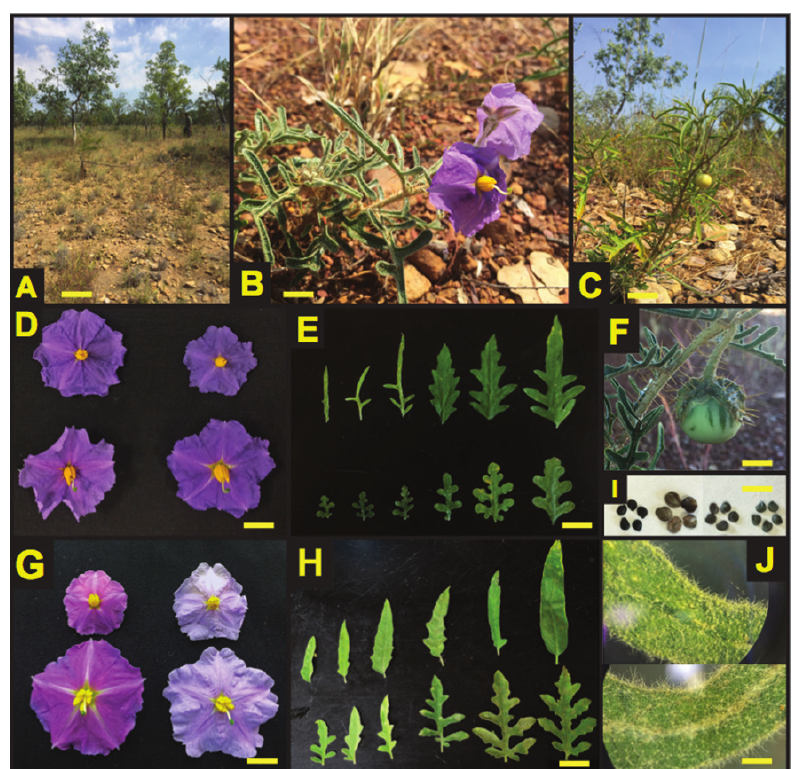
Figure 2. Solanum jobsonii Martine, J.Cantley, and L.M.Lacey and related species. A Typical habitat in clay soils with limestone stones and laterite pebbles, Limmen National Park, NT B S. jobsonii in flower and C in mature fruit D Corolla comparisons of staminate (upper) and hermaphrodite (lower) flowers for S. jobsonii (left) and S. diversiflorum (right) E Leaf shape across varying leaf ages for S. jobsonii (top) and S. diversiflorum (bottom) F S. jobsonii immature fruit with armed calyx G Corolla comparisons of staminate (upper) and hermaphrodite (lower) flowers for S. eburneum (left) and S. watneyi (right) H Leaf shape across varying leaf ages for S. watneyi (top) and S. eburneum (bottom) I Seed size, shape, and color comparisons from left to right – S. jobsonii , S. diversiflorum , S. eburneum , and S. watneyi J S. job- sonii trichome density of apical adaxial leaf surface (top) and apical abaxial leaf surface (bottom). Photos A, B, C, F, G by J.T. Cantley; H by E.S. Frawley; D, E, I, J by L.M. Lacey. Yellow scale bars: B, D, F, G